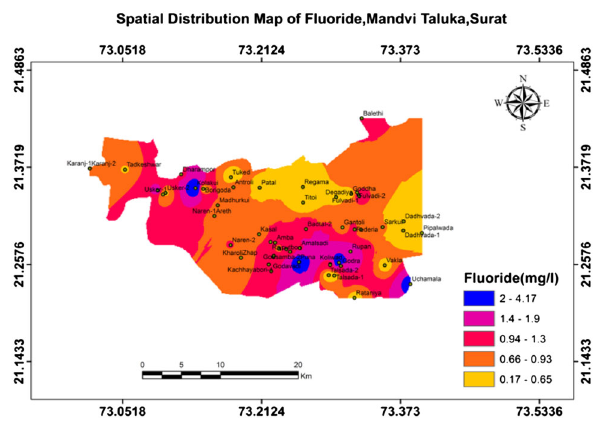
Fig. 4 Spatial distribution map of fluoride, Mandvi